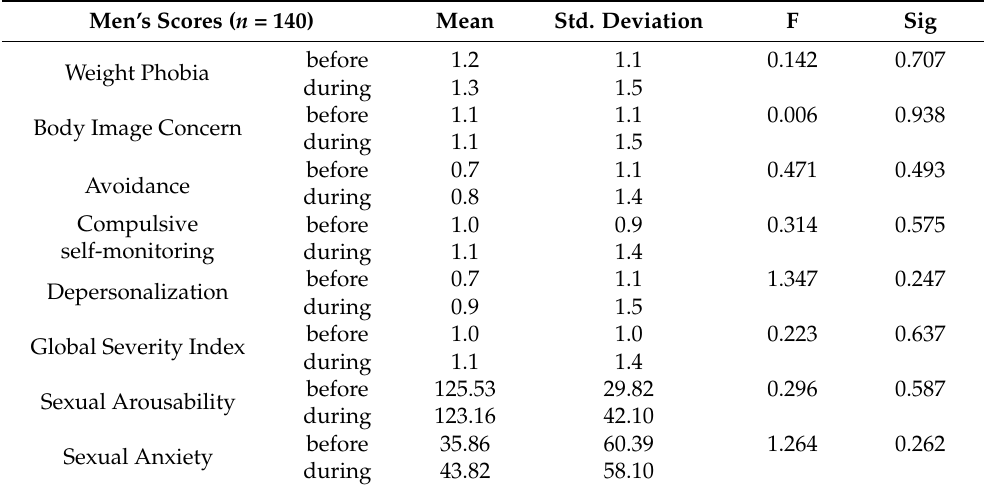
Table 3. Comparison of body variables and sexual arousal and anxiety before and during the lockdown in men. Men’s Scores ( n = 140) Mean Std. Deviation F Sig before 1.2 1.1 0.142 Weight Phobia during 1.3 1.5 before 1.1 1.1 Body Image Concern